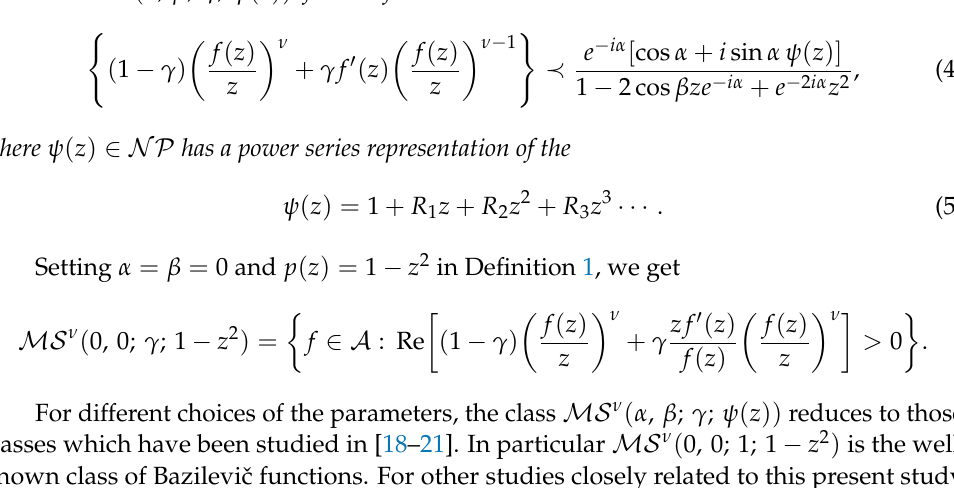
(cid:2) π (cid:3) , π ; p ( z ) if p ( z ) = 1 + z /1 − z 2 2